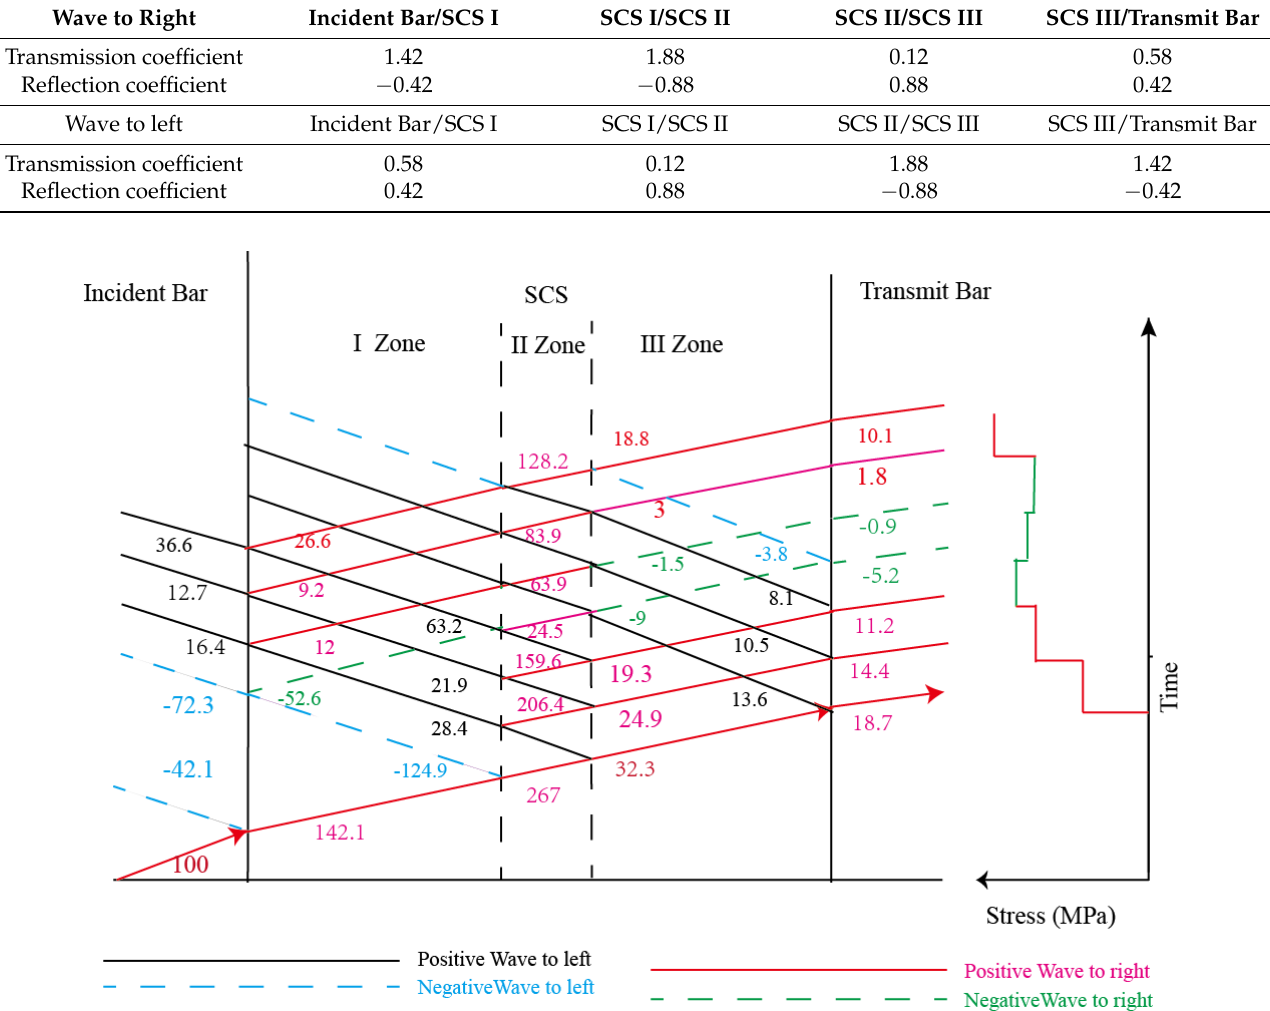
Table 6. Model parameters of finite element analysis (FEA). Length mm